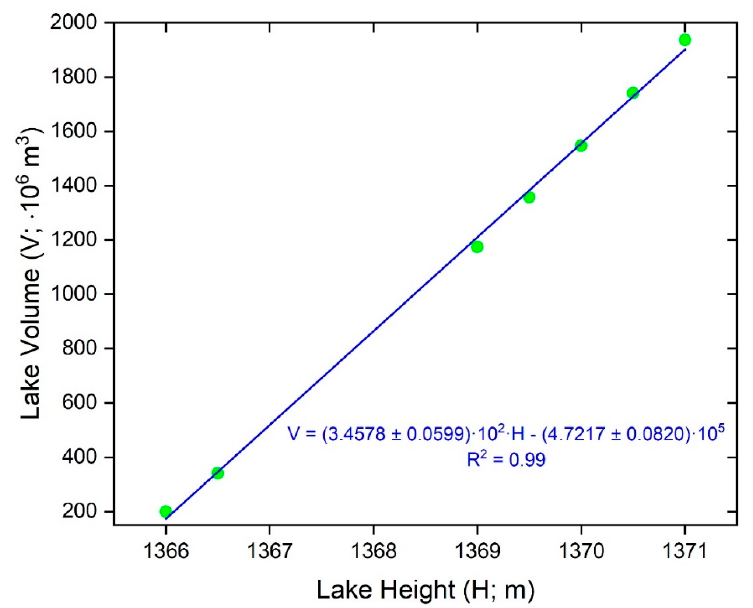
Figure 4. Linear correlation between lake volume and lake surface height in Utah Lake. The green dots show the lake volume calculated with ArcGIS corresponding to the lake heights of 1366.0, 1366.5, 1369.0, 1369.5, 1370.0, 1370.5, 1371 m.